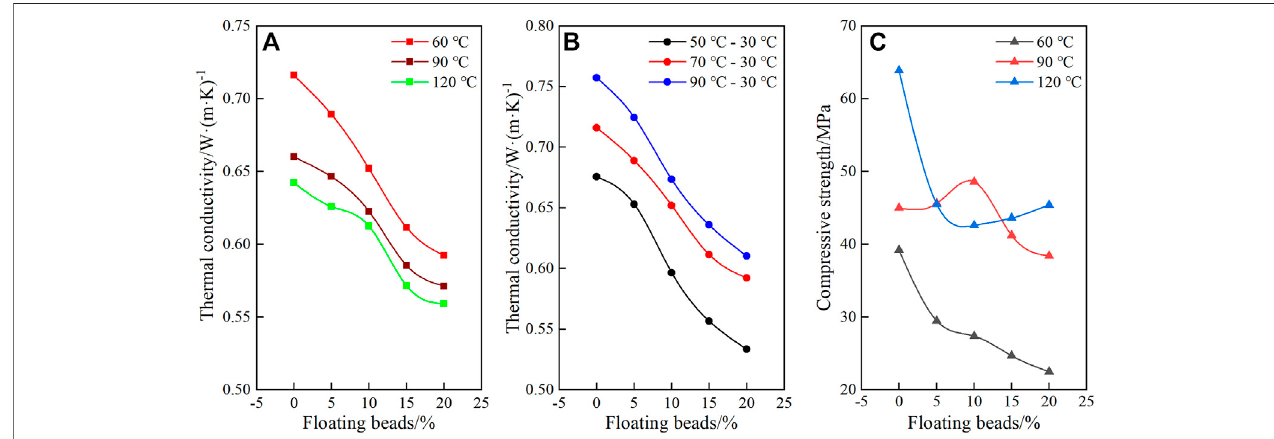
FIGURE7| Thermal conductivity and compressive strength test resultsofthermal insulation cement with fl oating beads underdifferentconditions. (A) Test results of thermal conductivity at different curing temperatures. The test temperature combination is 70 – 30 ° C. (B) Test results of thermal conductivity at different hot plate temperatures. The curing temperature is 60 ° C. (C) Test results of compressive strength at different curing temperatures.